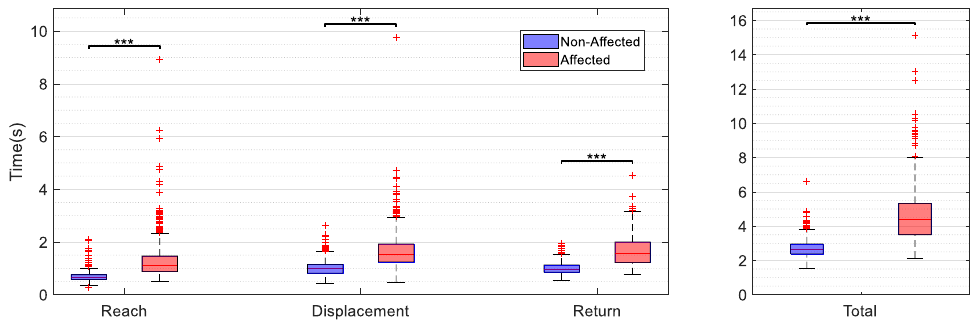
Figure A1. Movement time in seconds represented for the phases of reach, displacement and return and the total movement time. Data include all trials, object weights and target positions for the affected side (AF) and non-affected side (NAF).